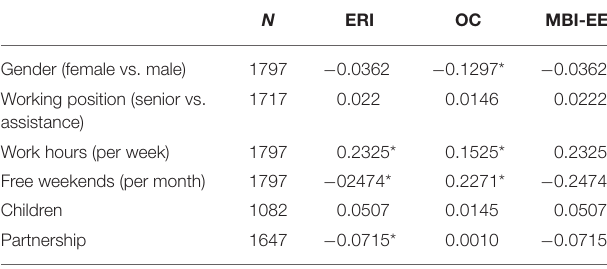
TABLE 4 | Results of the correlation analyses (combined 2006 and